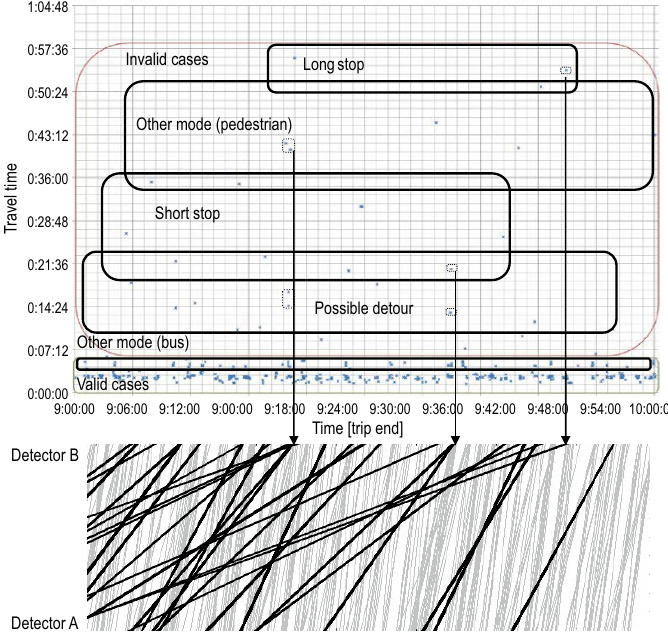
Fig. 1. Travel time values and trajectories between two